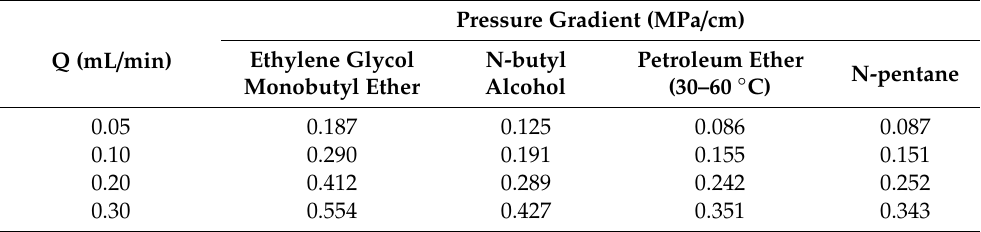
Table 5. Pressure gradient of di ff erent hydrocarbon agents at the temperature of 70 ◦ C.